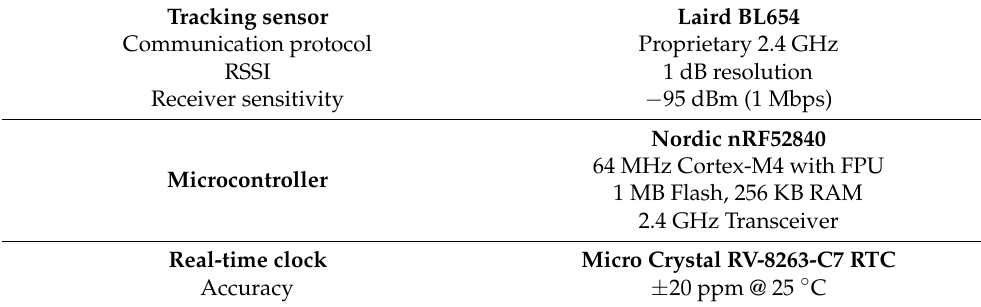
Table 1. Tracker device